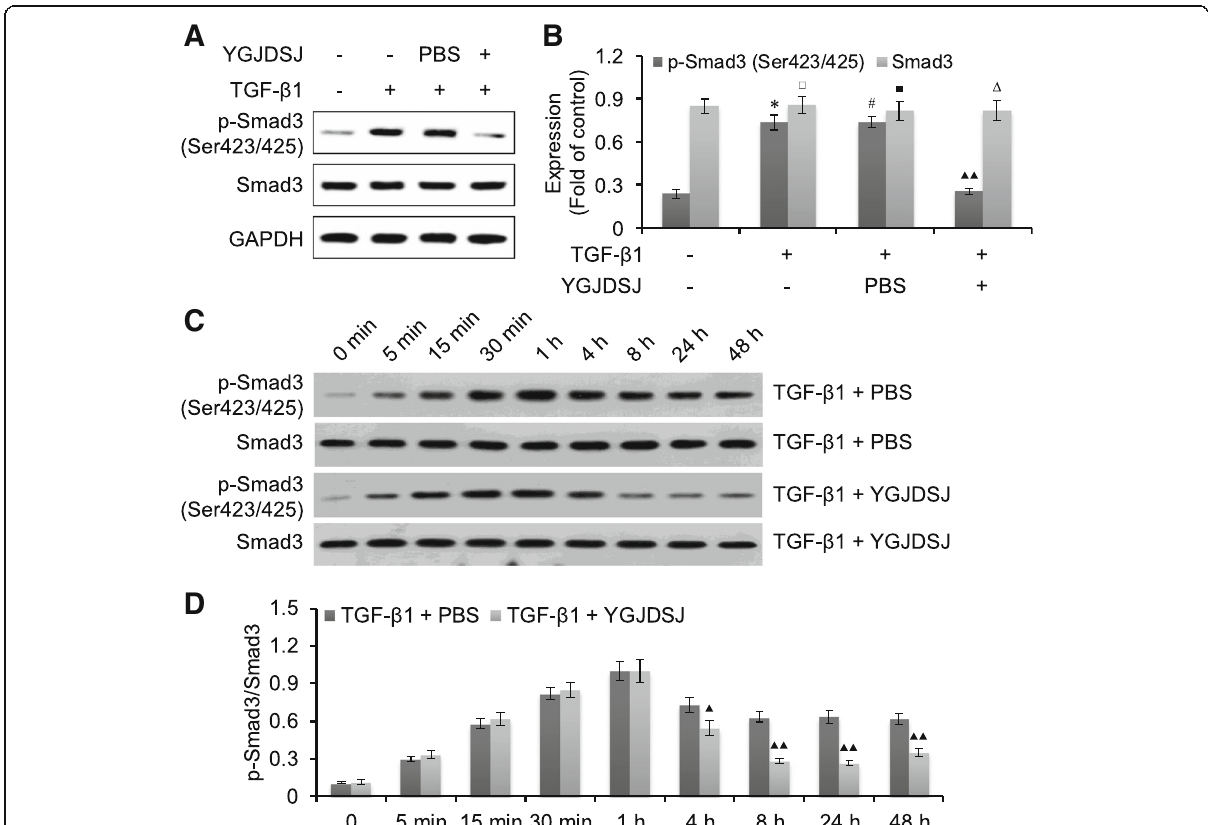
Fig. 3 Effects of YGJDSJ on TGF- β 1-induced Smad3 phosphorylation. a , Bel-7402 cells were treated with TGF- β 1 and YGJDSJ or PBS for 48 h, and subjected to western blotting using indicated antibodies. c , Bel-7402 cells were treated with TGF- β 1 and YGJDSJ or PBS for indicated times, and subjected to western blotting using Samd3 and p-Smad3. b and d , protein expression was quantified by the Quantity One software. * p < 0.01, versus control group; # p > 0.05, versus TGF- β 1 group; ▲ p < 0.05, versus PBS group; ▲▲ p < 0.01, versus PBS group; □ p > 0.05, versus control group; ■